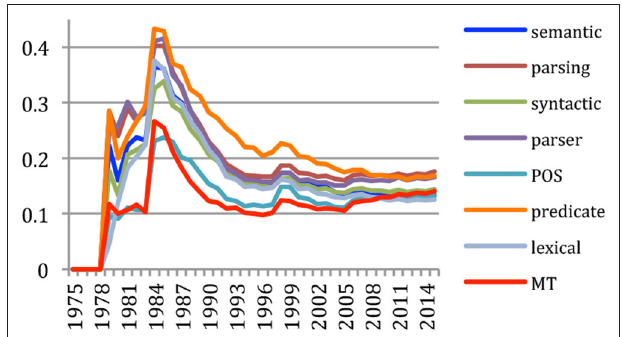
FIGURE 18 | Main domains within the ACL conference series (% of topical papers).